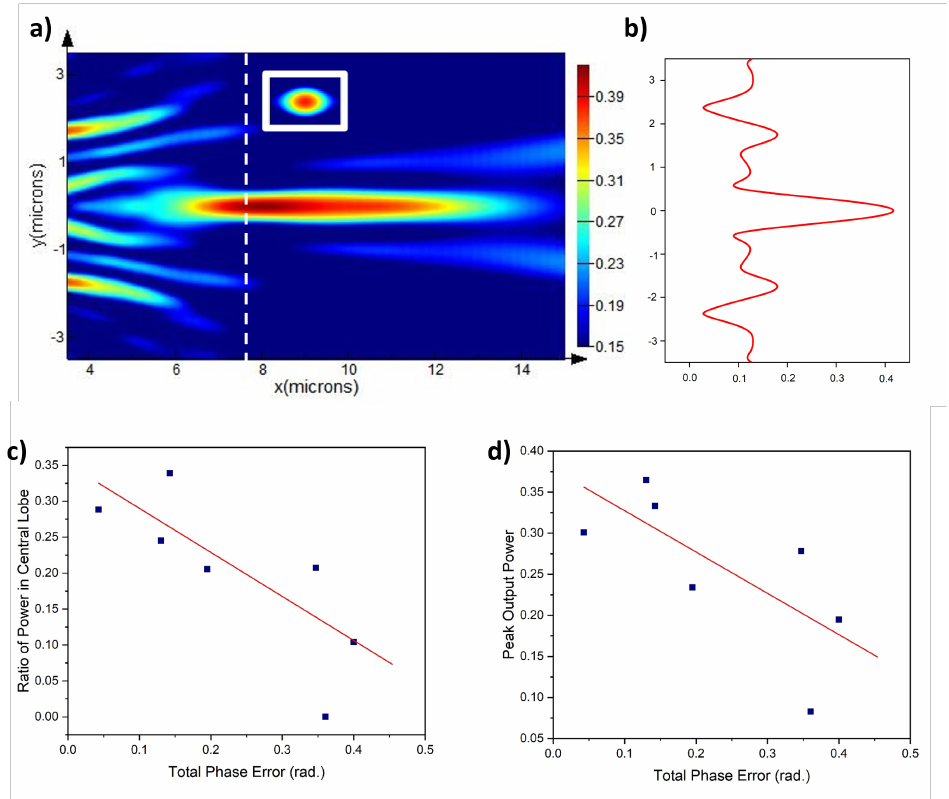
Figure 4. Central lobe and side lobes, as well as their relative power levels, are shown in ( a ) and ( b ) respectively. The inset shows the cross-section of the focal point. The relationship between total phase error and ( c ) ratio of power in the central lobe and ( d ) Peak output